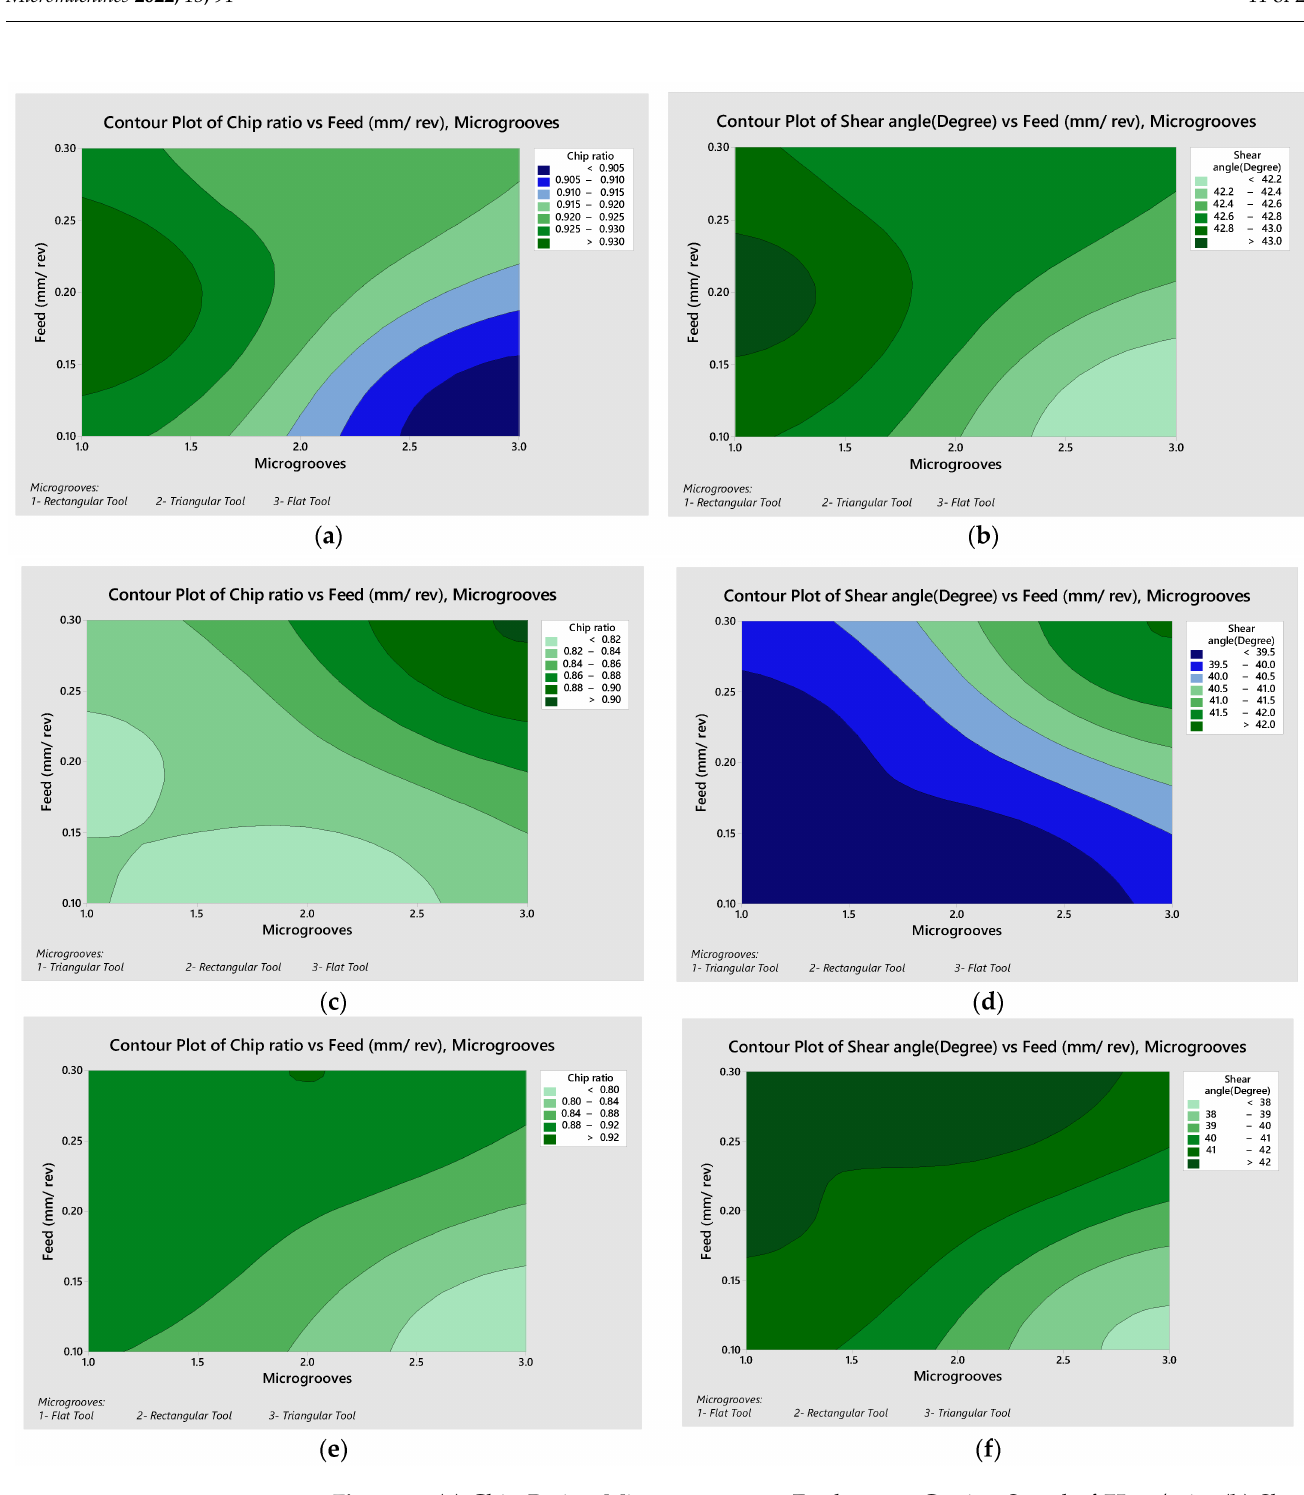
Figure 7. ( a ) Chip Ratio—Microgrooves vs. Feed rate at Cutting Speed of 75 m/min, ( b ) Shear Angle–Microgrooves vs. Feed rate at Cutting Speed of 75 m/min, ( c ) Chip Ratio—Microgrooves vs. Feed rate at Cutting Speed of 150 m/min, ( d ) Shear Angle—Microgrooves vs. Feed rate at Cutting Speed of 150 m/min, ( e ) Chip Ratio—Microgrooves vs. Feed rate at Cutting Speed of 225 m/min, ( f ) Shear Angle—Microgrooves vs. Feed rate at Cutting Speed of 225